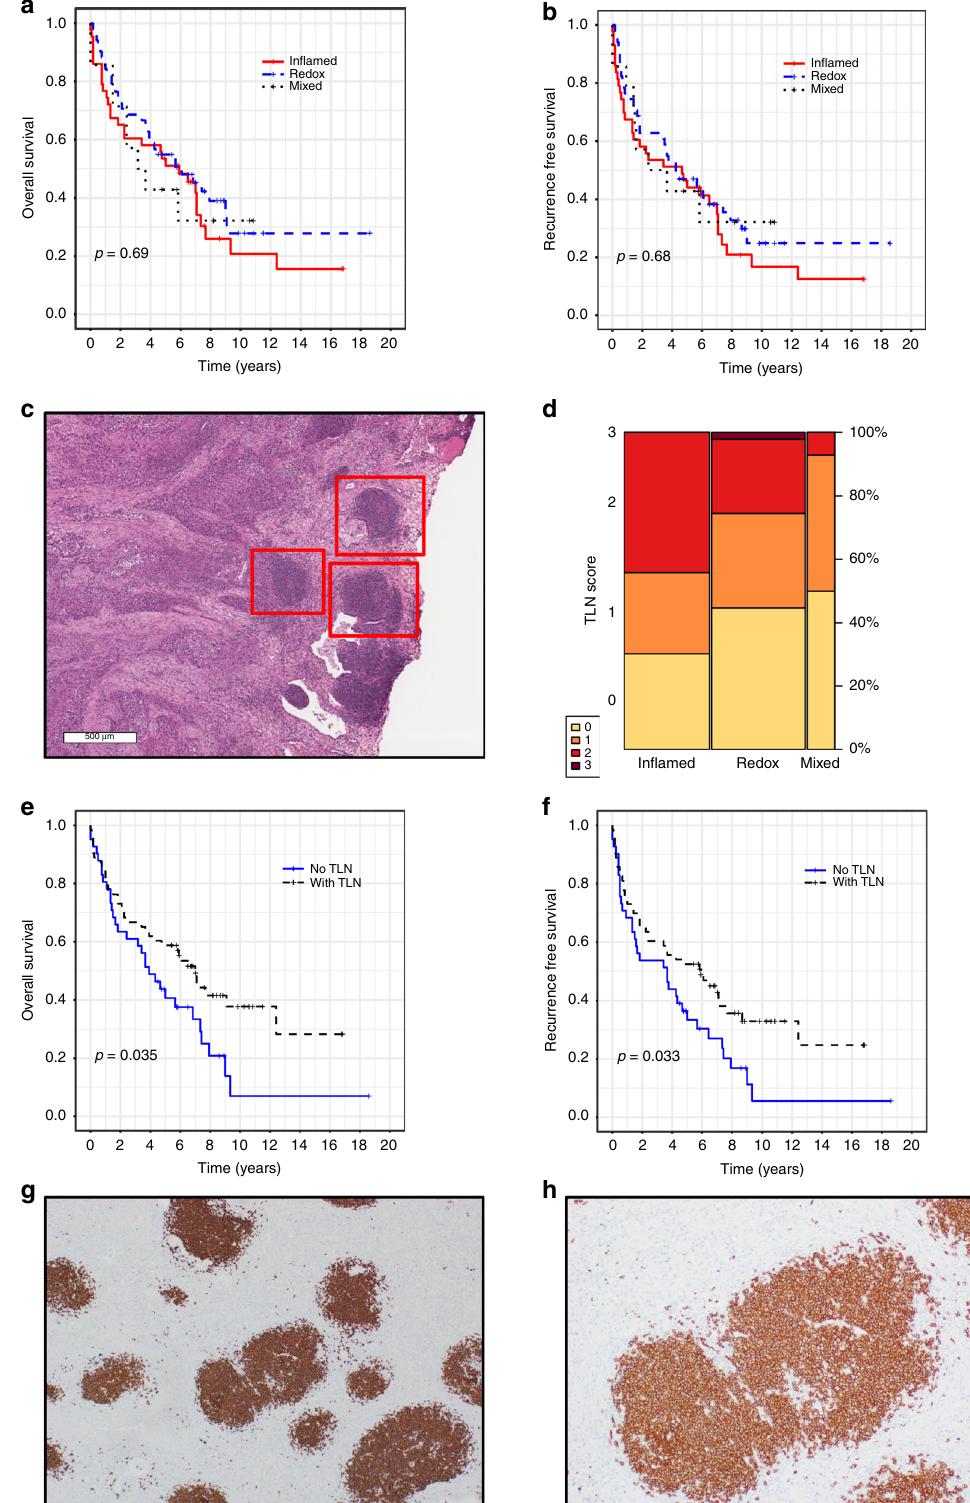
Fig. 4 Tertiary lymph nodes (TLN) are enriched in the In fl amed subtype and are associated with better outcomes. a , b Proteomic subtypes are not associated with overall or recurrence-free survival. c TLN, indicated by red boxes, are observable in H&E stained slides under low magni fi cation. d TLN can be observed in all three proteomic subtypes but are enriched in In fl amed (Cochran-Mantel-Haenszel P = 0.036). The height of each rectangle is proportional to the TLN score in a given subtype, and the width of each column is proportional to the number of samples in each subtype. e , f Presence of TLN provided a bene fi t to both overall and recurrence-free survival. g , h Immunohistochemical staining shows TLN primarily consist of CD20 + memory